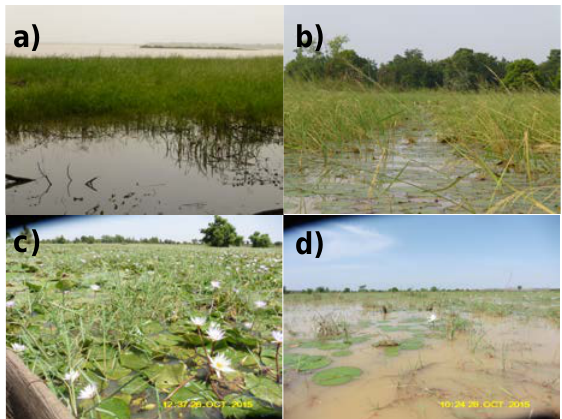
Figure 3. Ground truth photos taken during the October 2015 field campaign: (a) flooded grasses seen from the shoreline, (b) flooded grasses from the lake towards the shoreline, (c) dense water lilies, and (d) sparse flooded vegetation in shallow waters, photos by R. Ouedraogo and L. Moser